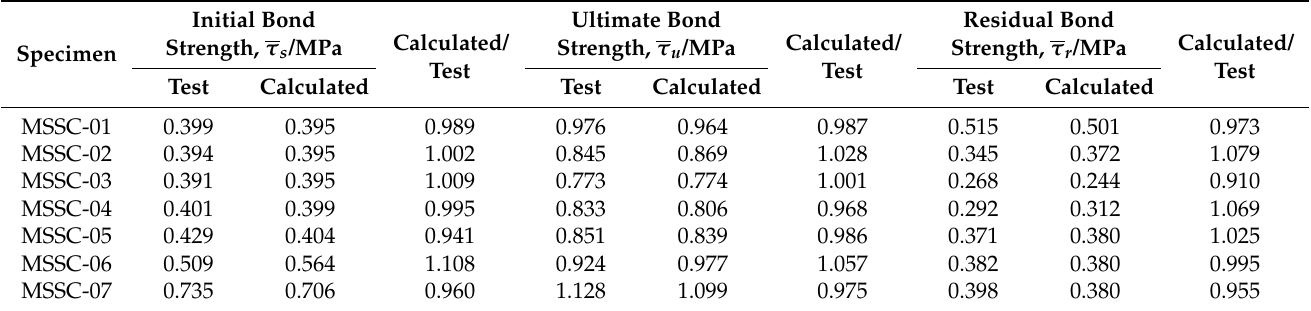
Table 5. Comparison of test and calculated values on characteristic average bond